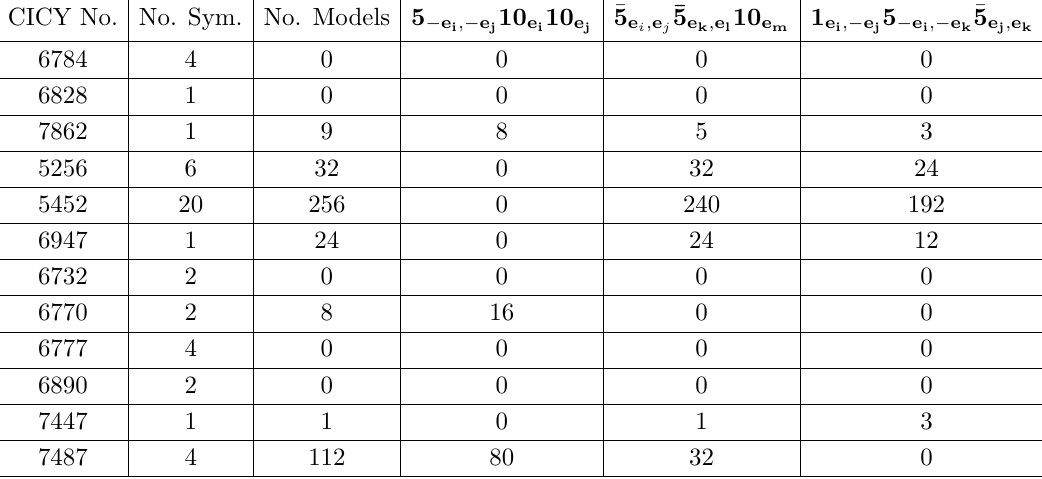
Table 5 . The number of Yukawa couplings of various types that are permitted by the gauge symmetries but vanish due to the topological restriction (5.2) for the set of Line Bundle Standard Models being considered [19, 20, 105]. The (cid:12)rst column gives the CICY identi(cid:12)cation number of the manifold on which the models are based, according to the standard list [75, 104]. The second column details how many symmetries are being considered, and thus the number of downstairs manifolds that each row corresponds to. ‘No. Models’ gives the number of models with at least one Yukawa coupling that vanishes due to this topological consideration. The remaining three columns give the number of each type of such couplings that vanish due to (5.2) in this set of models.